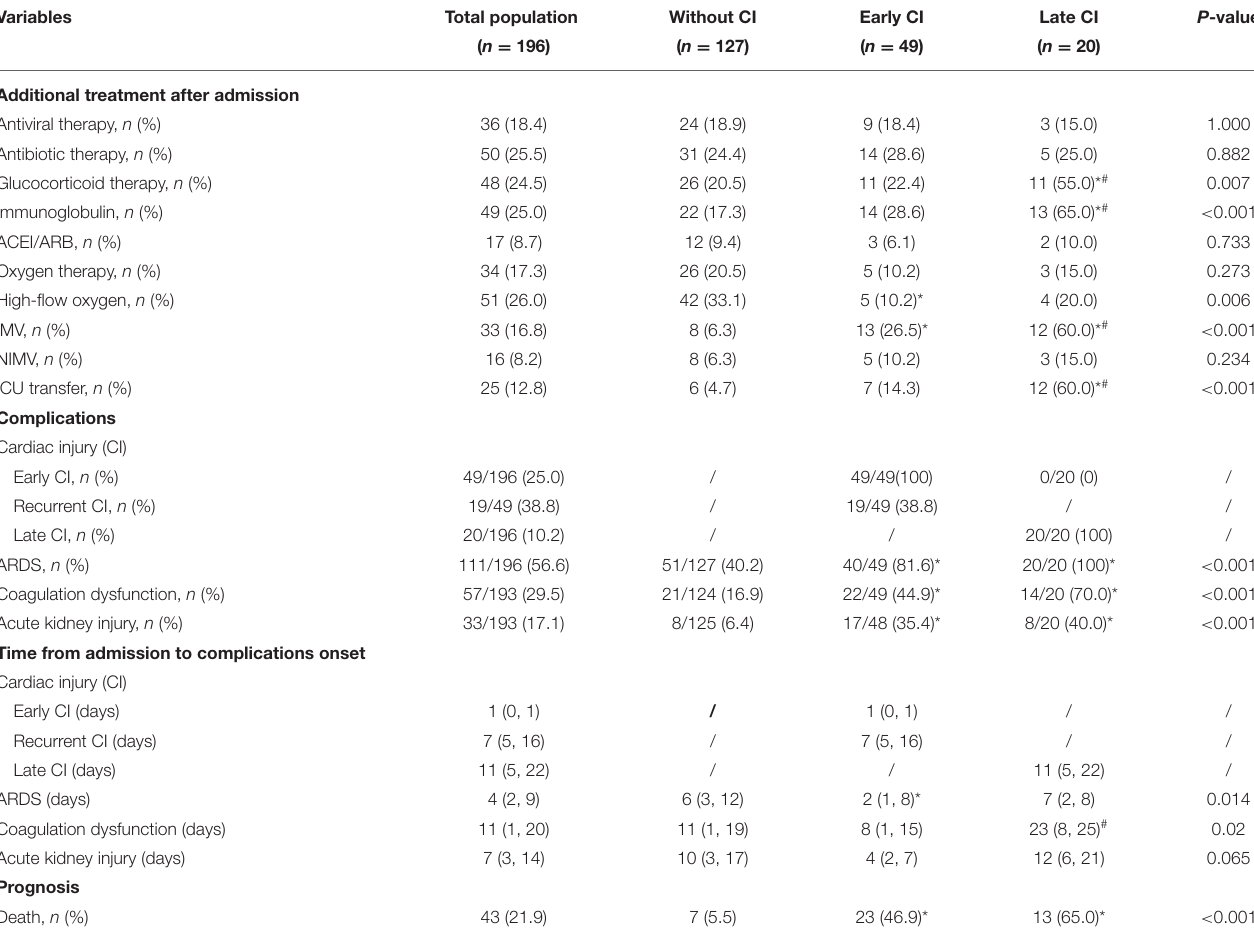
TABLE 2 | Comparisons of additional treatment, complications, and prognosis after 72h of admission among the three groups. Variables Total population Without